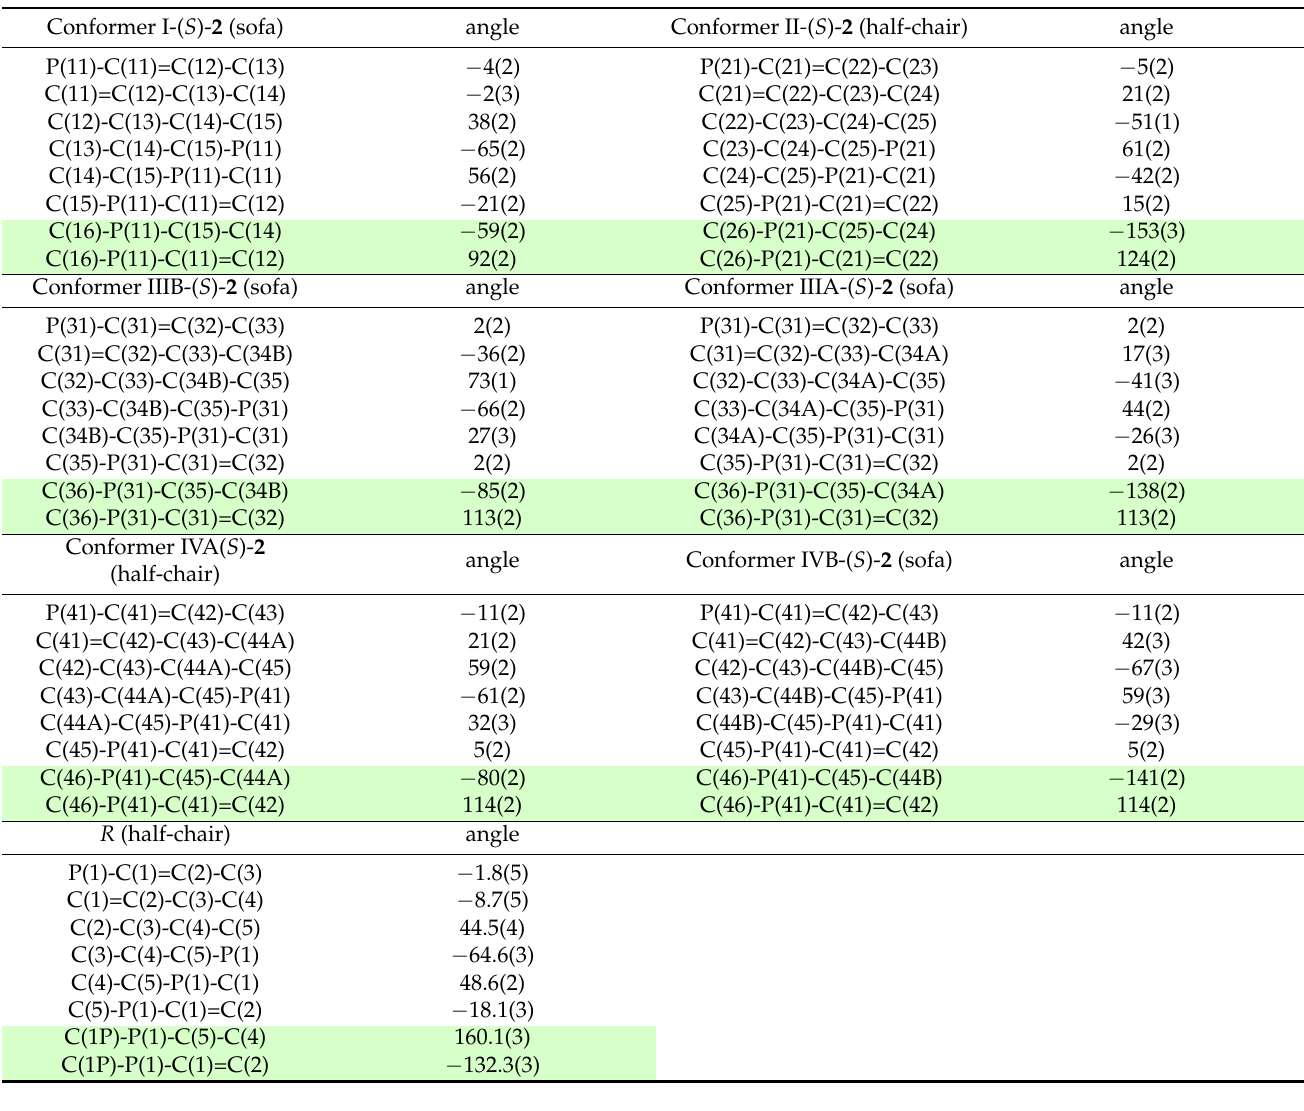
Table 1. Endocyclic torsion angles ( ◦ ) for phosphinenone ring and exocyclic torsion angles describing orientation of substituents on P-atom in the enantiomeric molecules ®- 2 and ( S )- 2 . Conformer I-( S )- 2 (sofa)